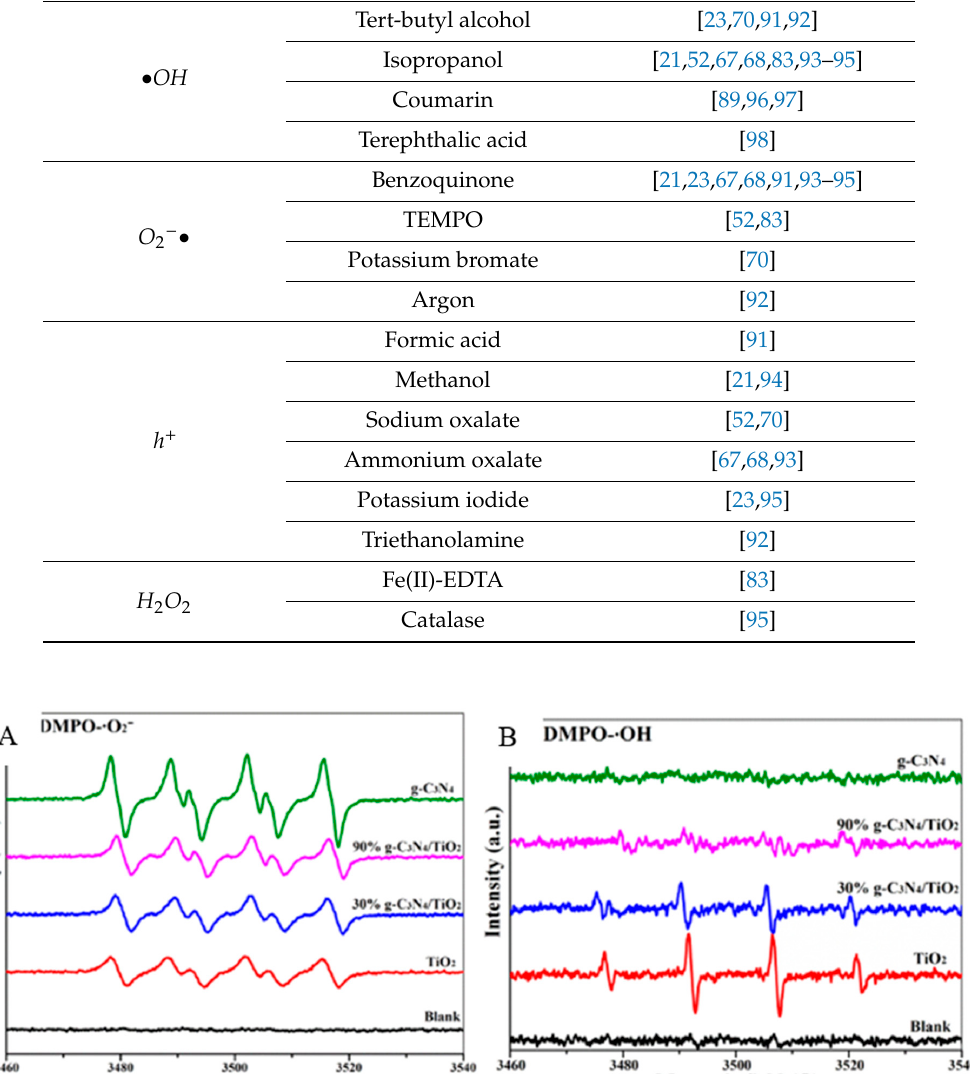
− • and ( B ) DMPO- • OH of pure TiO